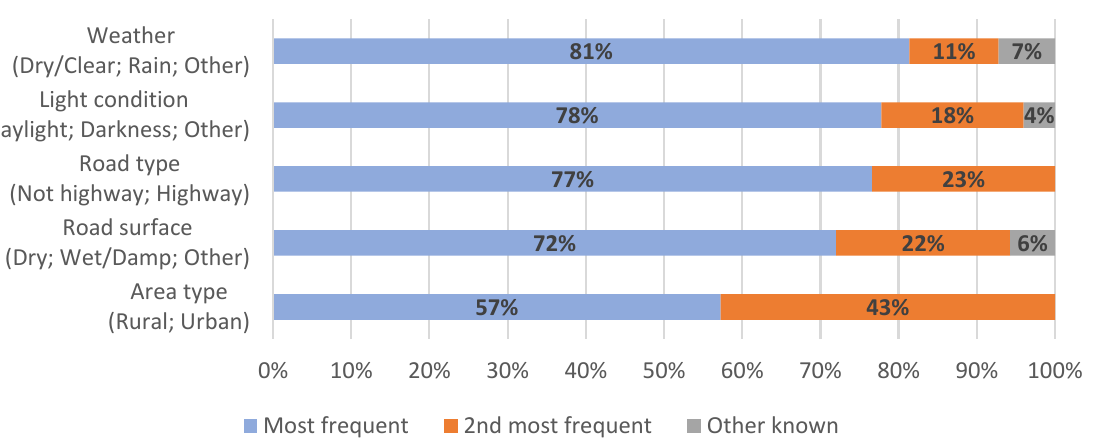
Figure 4. Characterization of crashes involving heavy goods vehicles (HGVs) in Europe in terms of environmental variables, based on Community Database on Accidents on the Roads in Europe (CARE) data.